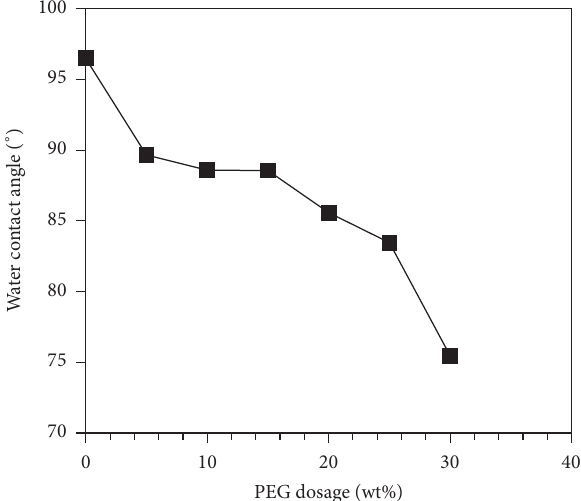
Figure 3: Water contact angle versus an increase in the PEG concentration